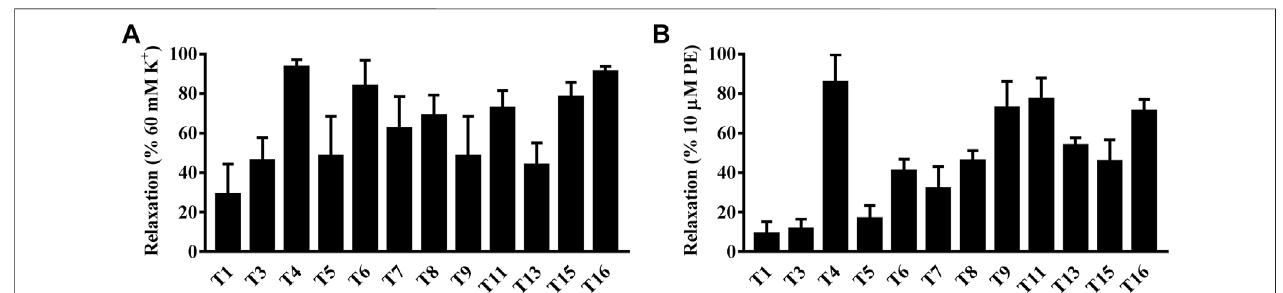
FIGURE6| Vasodilationeffectsoftargetcompoundsonsuperiormesentericarteryrings invitro pre-contractedbyKCl(60 mM)orbyphenylephrinehydrochloride (PE, 10 μ M). (A) KCl. (B) PE.